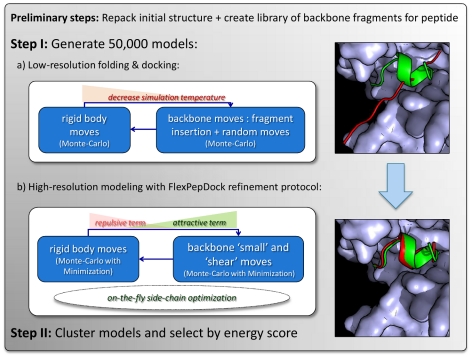
General outline of the Rosetta FlexPepDockab-initio protocol.See Text for more details.